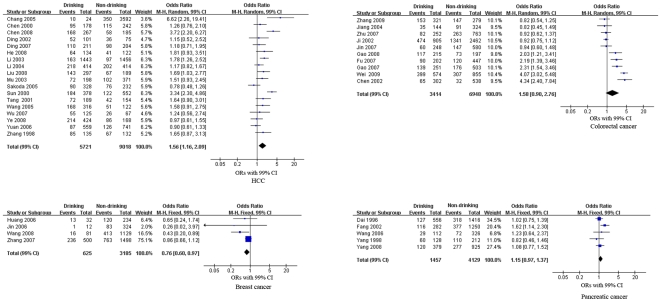
Forest plot of relative risk estimates of incident HCC, colorectal cancer, breast cancer and pancreatic cancer by alcohol consumption in Chinese.This figure shows forest plots for the meta-analysis of the association between alcohol consumption and the risk of HCC, colorectal cancer, breast cancer and pancreatic cancer. OR and the 99% CI for each cancer was given.